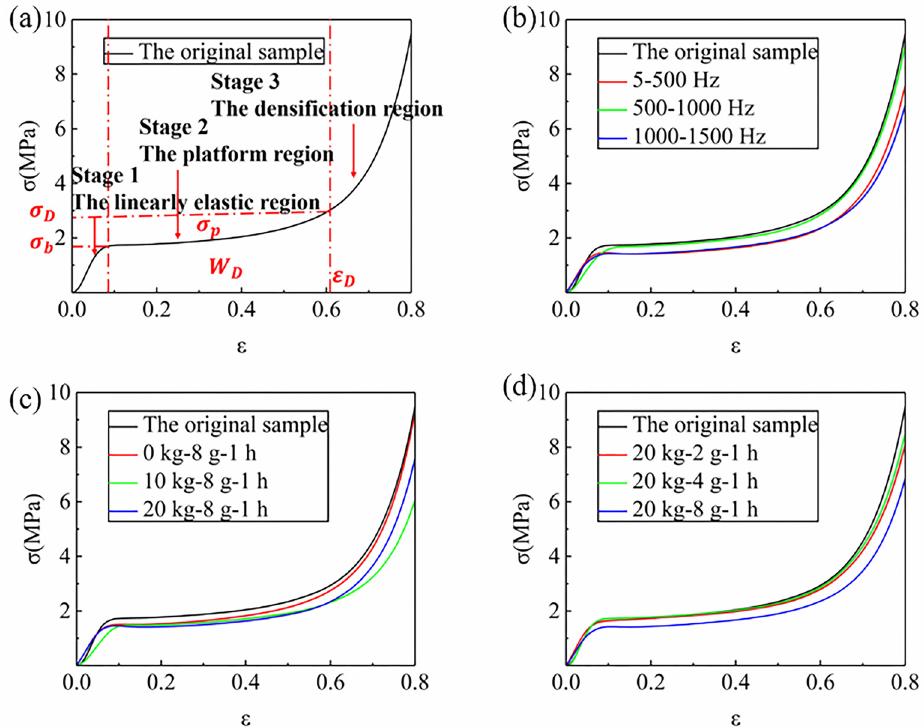
Figure 4. Compressive engineering stress-strain curves of the RPUF, ( a ) Schematic diagram of the foam compression stage, ( b ) Different frequency ranges, ( c ) Different mass blocks, ( d ) Different accelerations.